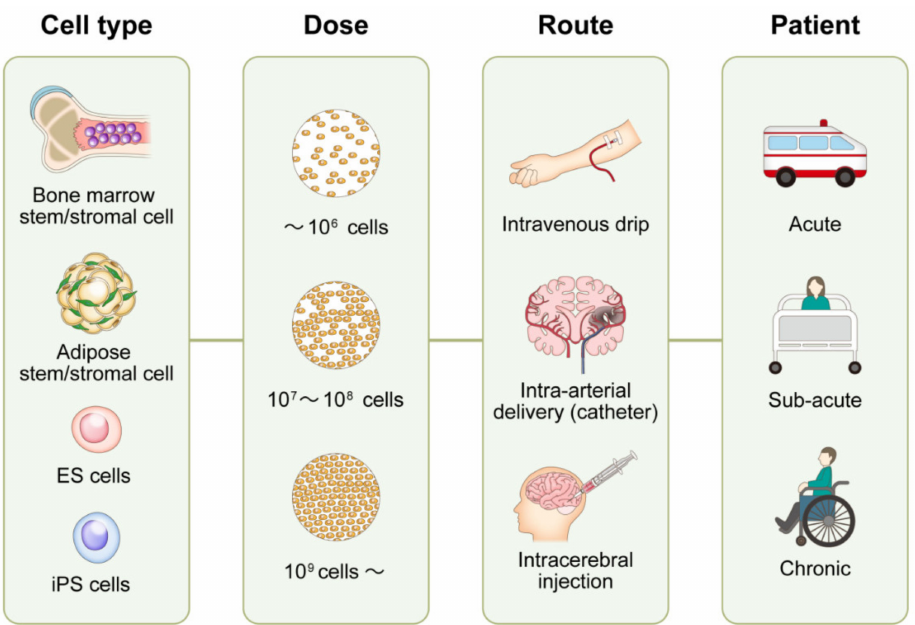
Figure 1. Unsolved issues regarding stem cell treatment for ischemic stroke. The most e ff ective and safest method of stem cell therapy has not been established. The challenges include the choice of cell, cell dose, transplantation routes, and patient type. ES cell: embryonic stem cell, iPS: induced pluripotent stem